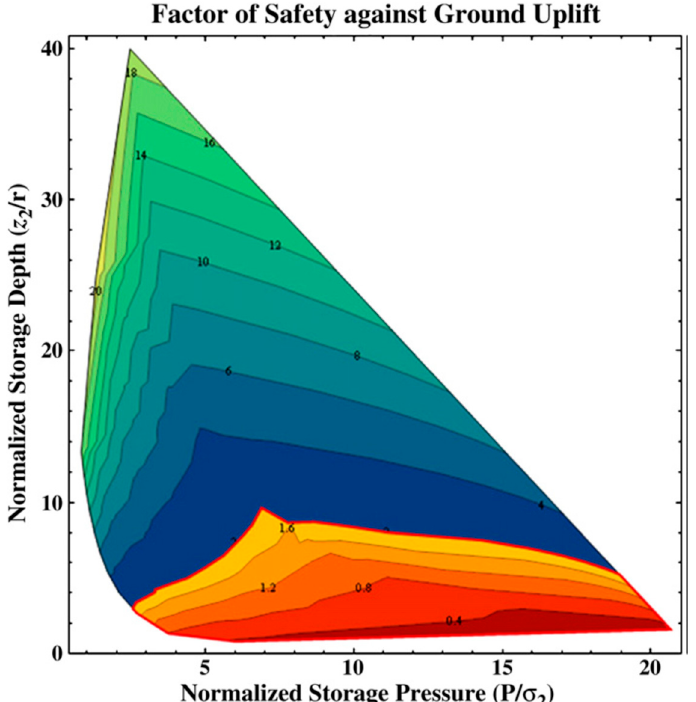
Figure 1. Three models for action of ground against lift-up due to gravity. W is weight, alpha is the angle of friction of the rock mass, usually 30 – 45 degrees [19].